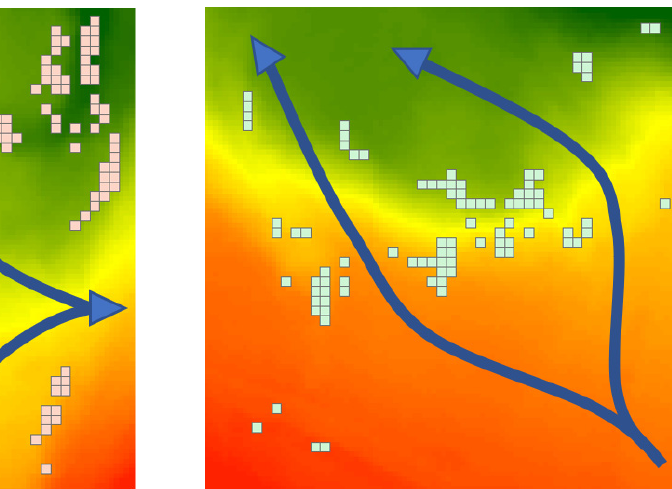
Figure 19. Movement corridors that avoid impassable areas.